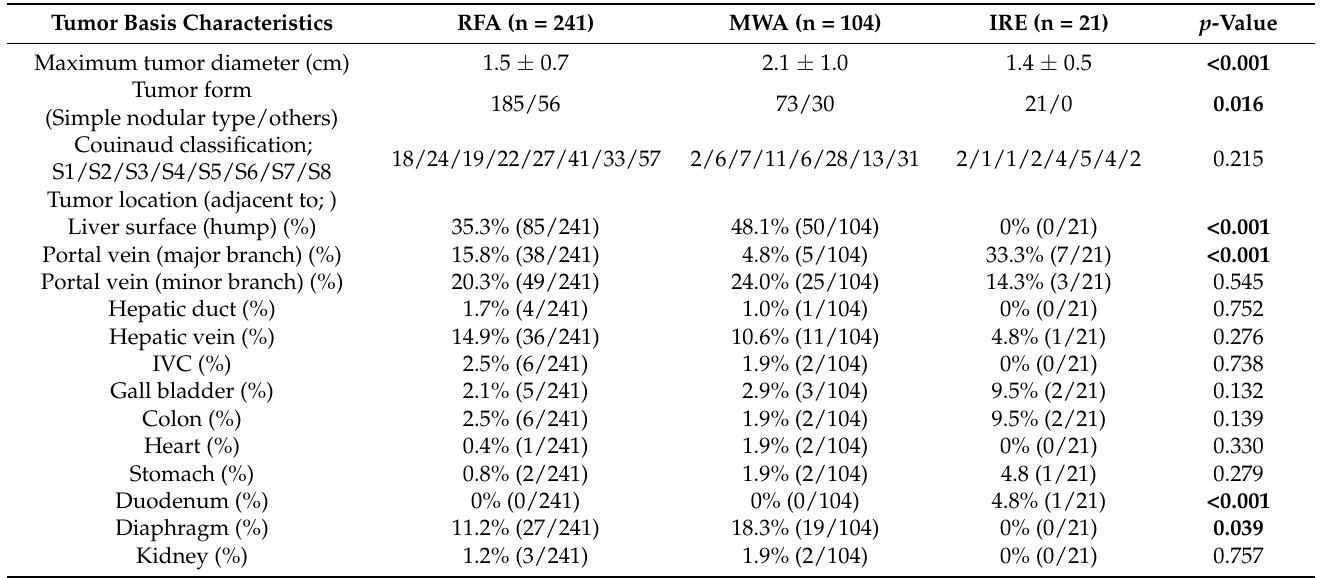
Table 2. Tumor characteristics according to three different ablation